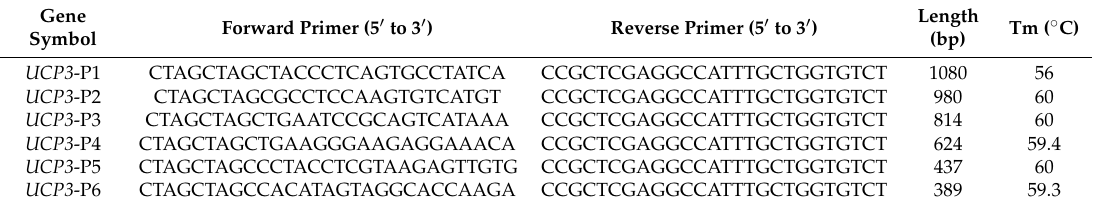
Table 5. The system of experimental group and control group.